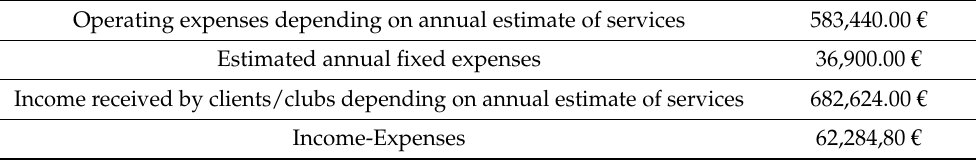
Table 15. Annual estimated profit depending on the annual estimate of expenses and incomes.